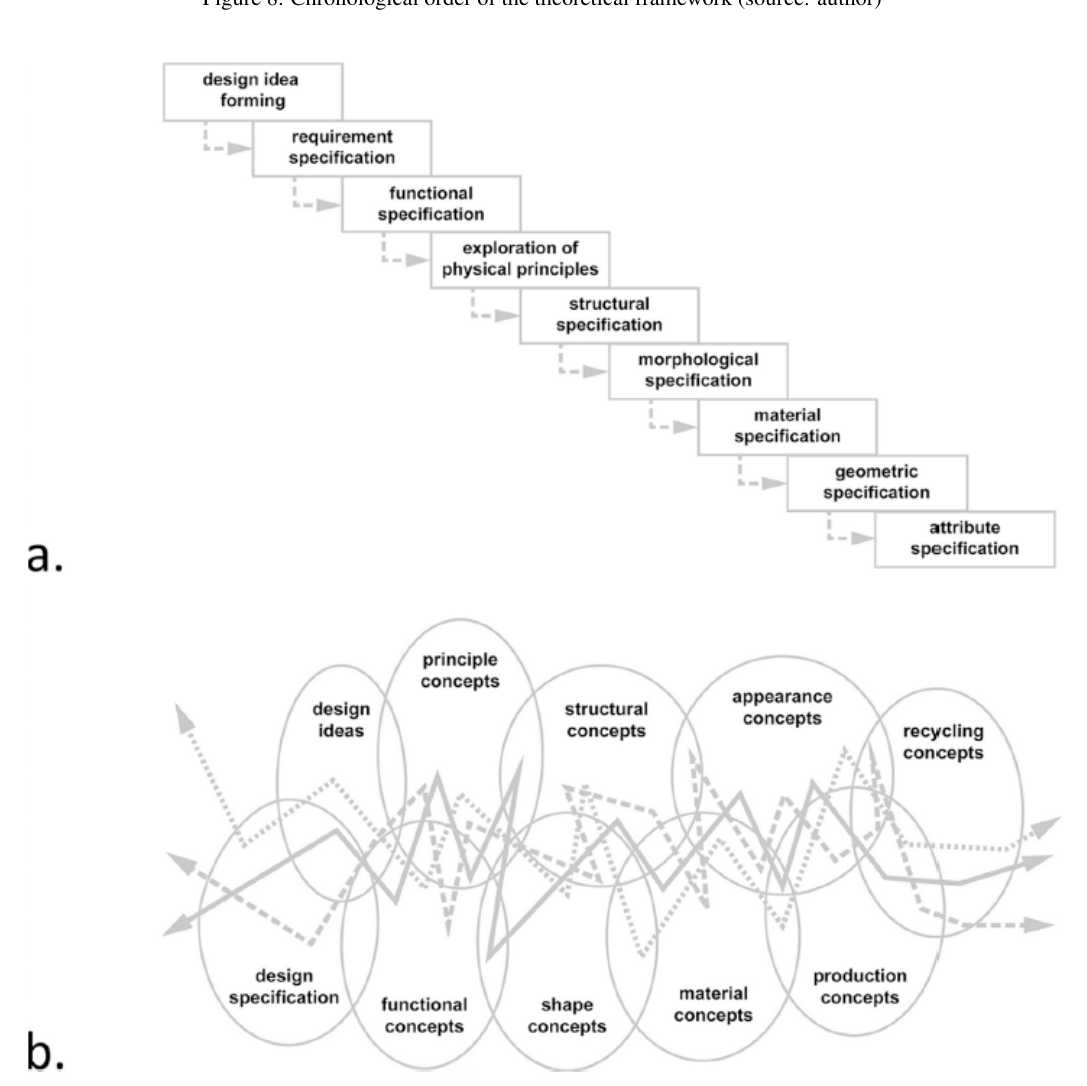
Figure 9. Shows the two existing structured frameworks for the conceptual design process before the appearance of the theoretical framework of kinetic architecture (source: Zboinska et